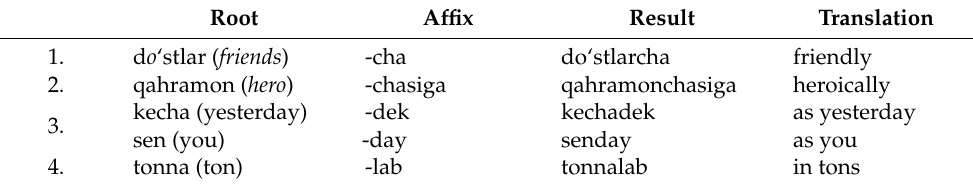
Table 10. Different forms of